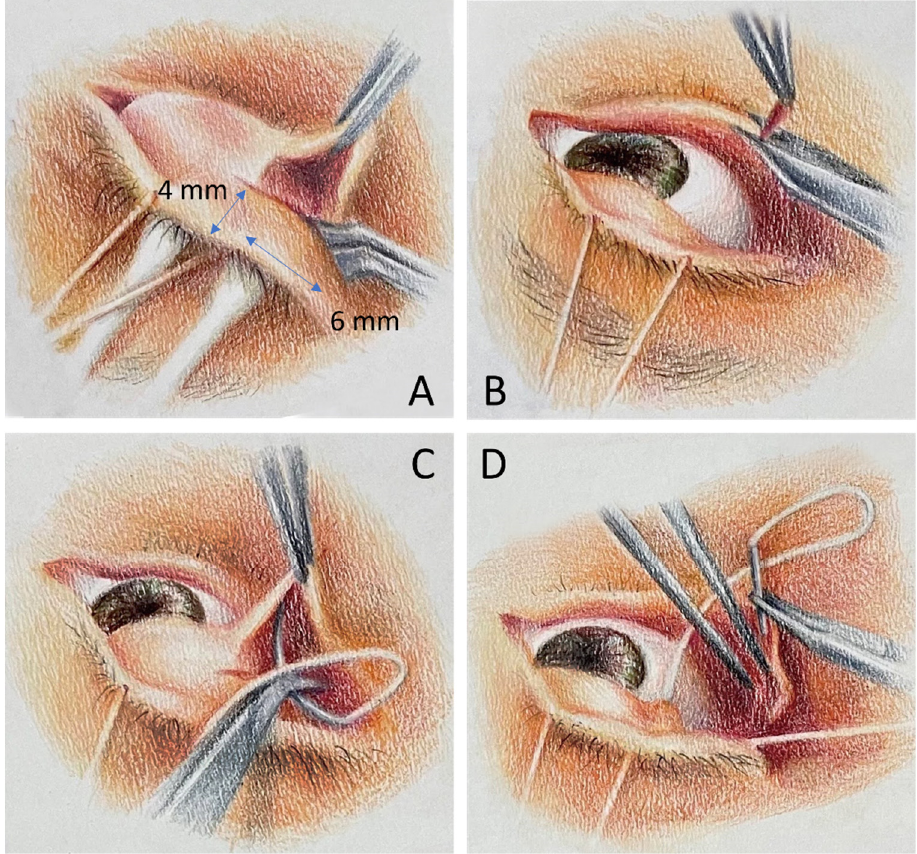
Figure 1. Surgical procedures illustration of lateral tarsoconjunctival flap (LTF). Briefly, an area measuring 4 mm (vertical length) × 4–6 mm (horizontal length) from the lid margin was marked over the tarsal conjunctiva to create a partial tarsal graft after the upper lid was everted ( A ). Then, the lateral 4–6 mm aspect of the lower lid margin was denuded posterior to the grey line with 15-blade or Westcott scissors ( B ). Finally, one or two interrupted, 5-0 Vicryl sutures were placed at the inferior edge of the upper eyelid flap and the denuded lower eyelid margin to create the LTF ( C , D ). One or two interrupted, 5-0 Vicryl sutures were placed at the inferior edge of the upper eyelid flap and the denuded lower eyelid margin (Figure 1C,D).